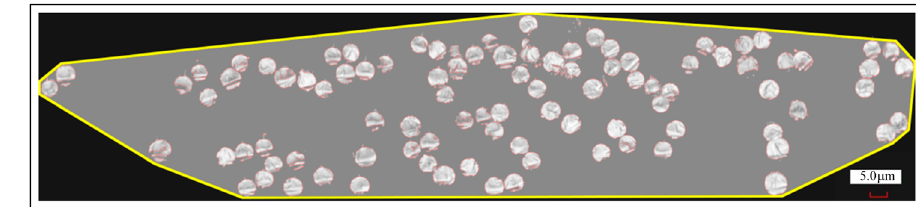
Figure 10: Evaluation of clustering property of D900 glass yarn.